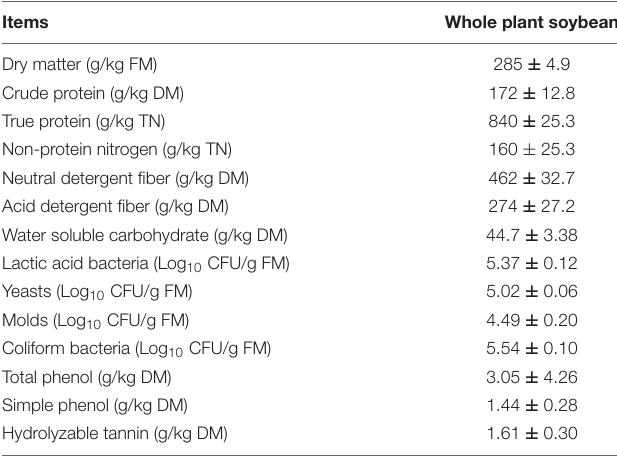
TABLE 1 | Chemical composition and microbial population of fresh whole plant soybean prior to ensiling ( ± SD, n = 3).